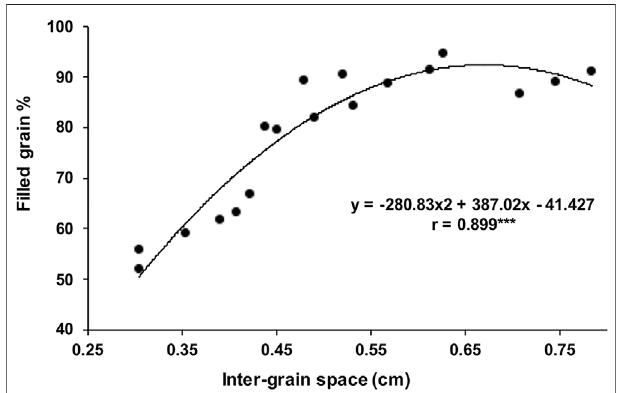
FIGURE 2 | Polynomial regression analysis between the fi lled grain percentage and inter-grain space. The correlation is signi fi cantly positive, and the curve suggests that while the grain fi lling increases with an increase in the inter-grain space, an inter-grain space greater 0.55 cm is of not much bene fi t for grain fi